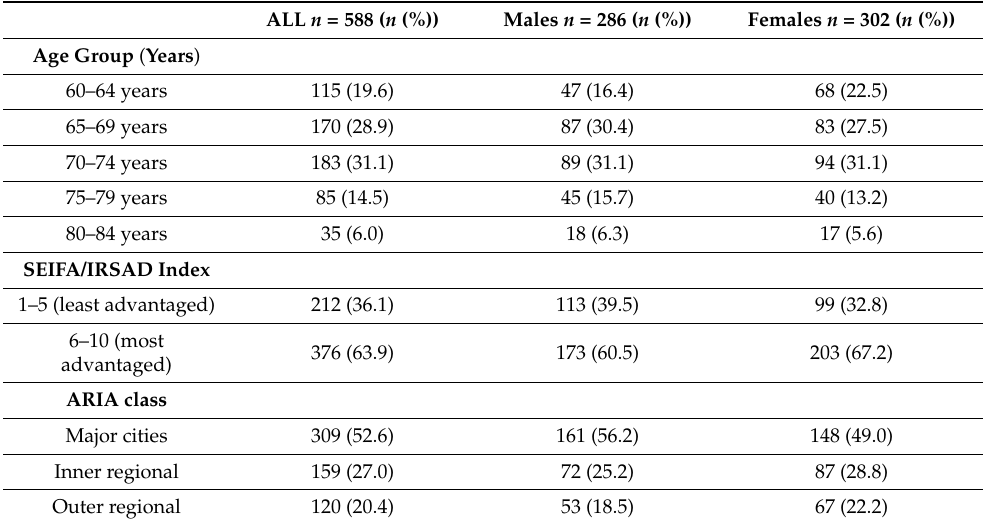
Table 1. Summary of demographic